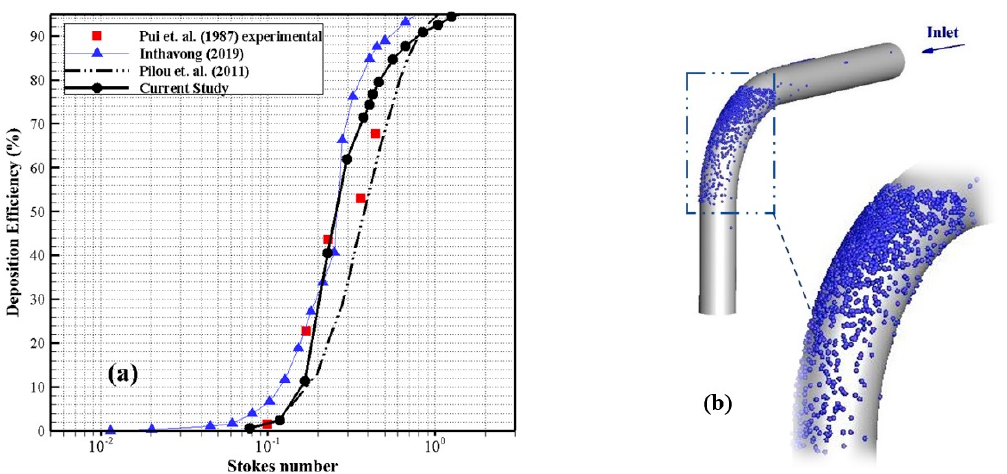
Figure 4. Validation of the deposition efficiency (DE) in a 90° bend. ( a ) Comparison of DE in current study with Pui et al. [30], Inthavong et al. [31], and Pilou et al. [32]. ( b ) Particle deposition pattern in a 90° pipe.